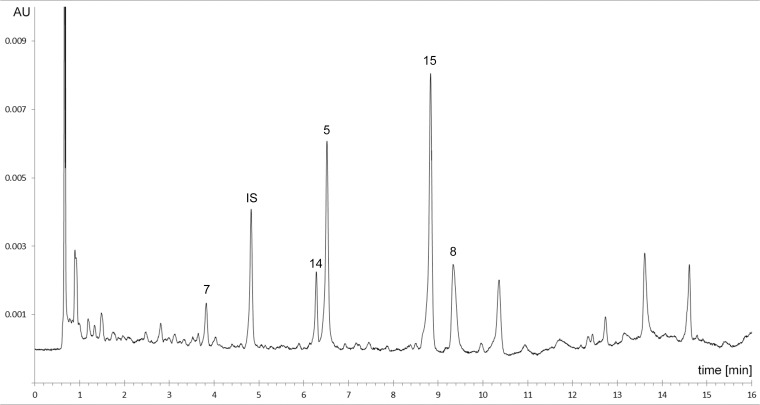
UHPLC of RA1 (1 mg/mL).
7 epicatechin-(4β→8)-epicatechin, 14 epicatechin-(4β-→8)-epicatechin(4β→8,2β→O→7)-epicatechin, 5 epicatechin-3-O-gallate, 15 quercetin-3-O-glucuronide, 8 epicatechin-3-O-gallate-(4β→8)-epicatechin-3-O-gallate, IS internal standard epigallocatechin-3-O-gallate.